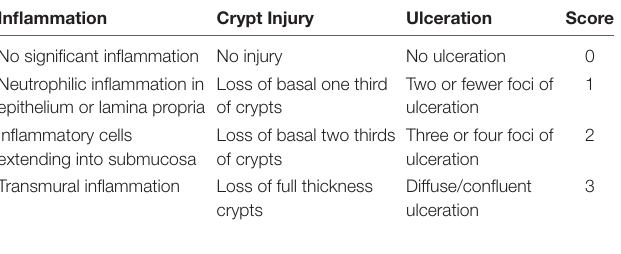
TABLE 1 | The histologic scoring system.